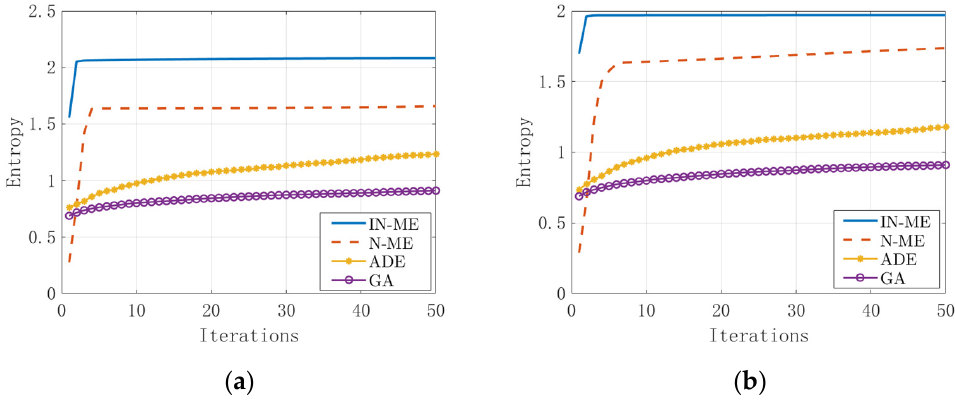
Figure 4. Comparison of different algorithms. ( a ) θ P = 0 ◦ ; ( b ) θ P = 6 ◦ .